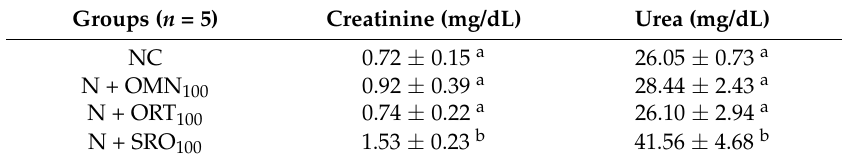
Table 3. Effect of aqueous extracts of Musa acuminata peels on serum creatinine and urea concentration in rats. Groups ( n =